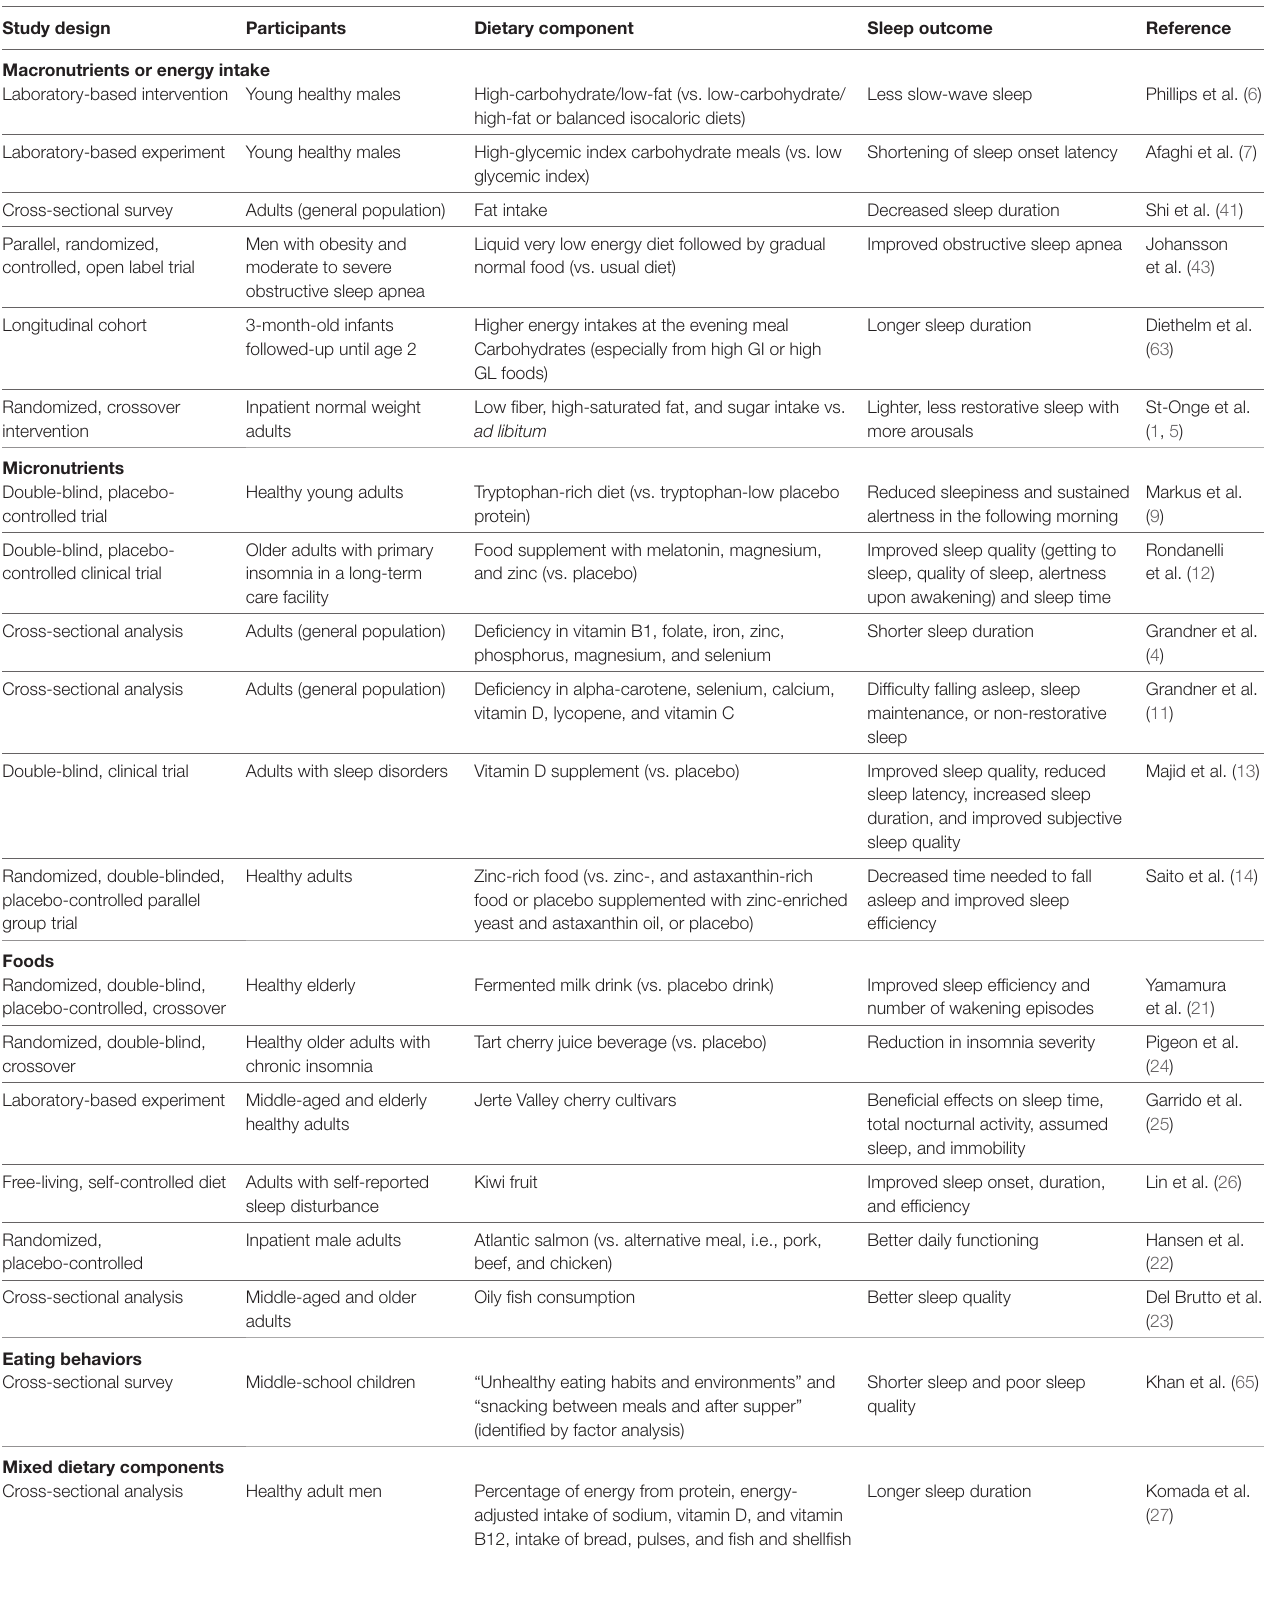
Table 1 | Example of studies linking dietary components and sleep